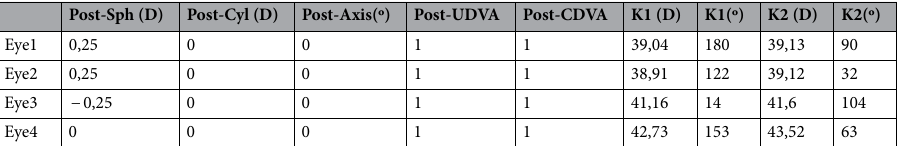
Table 2. Postoperative ocular parameters of the four eyes*. * Sph (sphere), Cyl (Cylinder), Axis (cylinder axis), CDVA (corrected distance VA), K1 and K2 (keratometries), K1 (º) and K2(º) (keratometric axis).